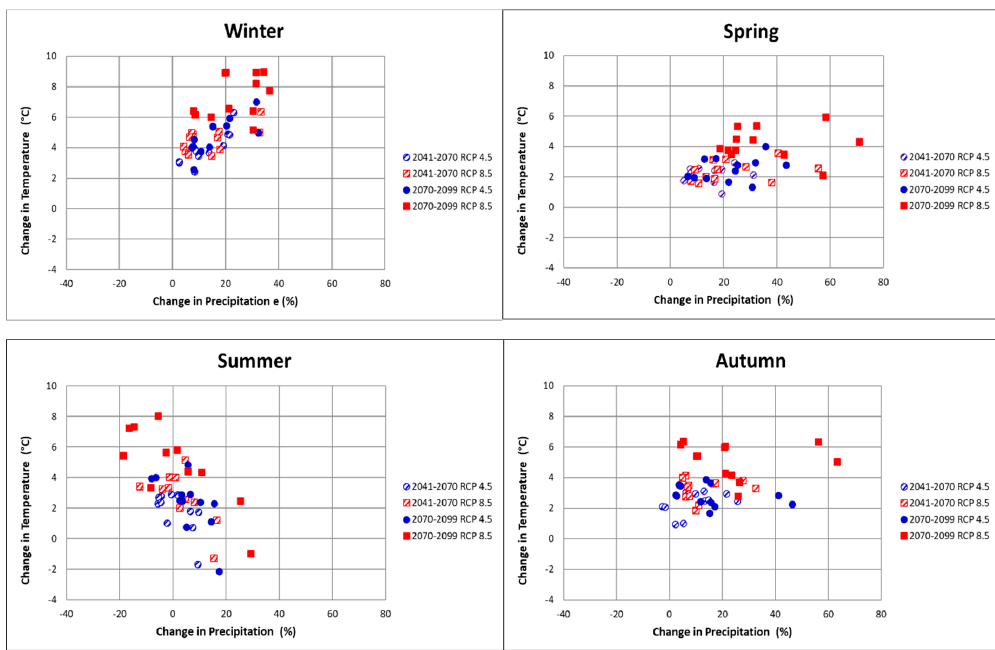
Figure 2. Projected changes in seasonal mean precipitation and air temperature over the Athabasca Figure2. watershed.